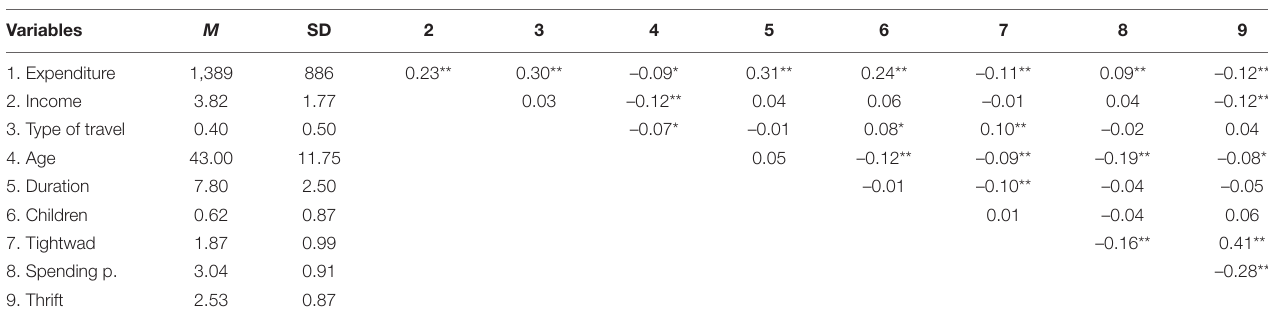
TABLE 2 | Means, standard deviations, and Pearson